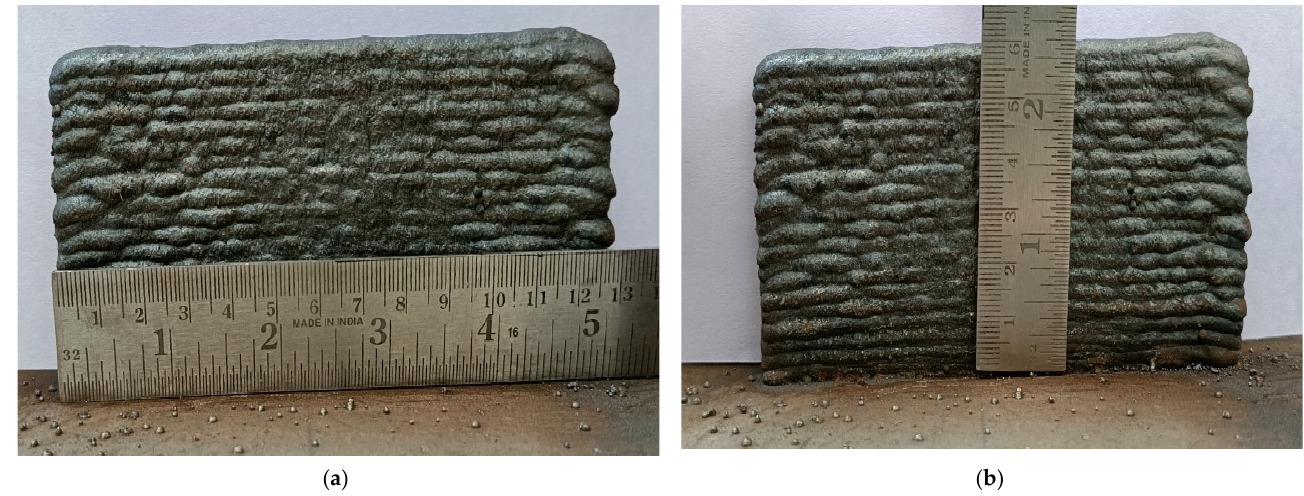
Figure 11. Multi-layered structure showing ( a ) length and ( b ) width on SS 316L substrate.